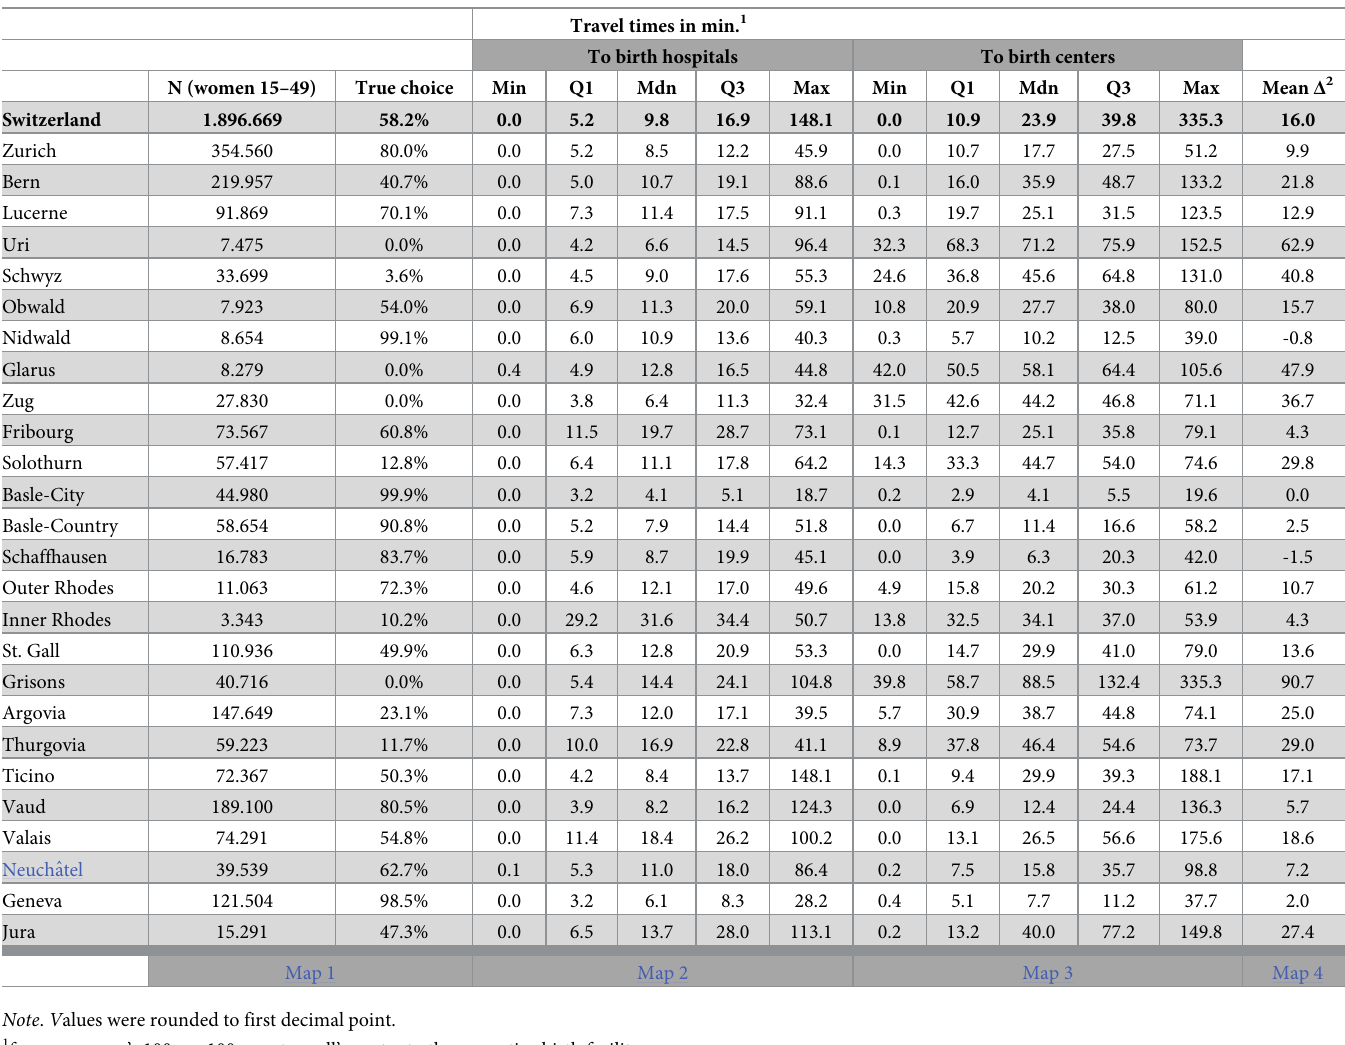
Table 1. Accessibility of birth settings at national and cantonal level.